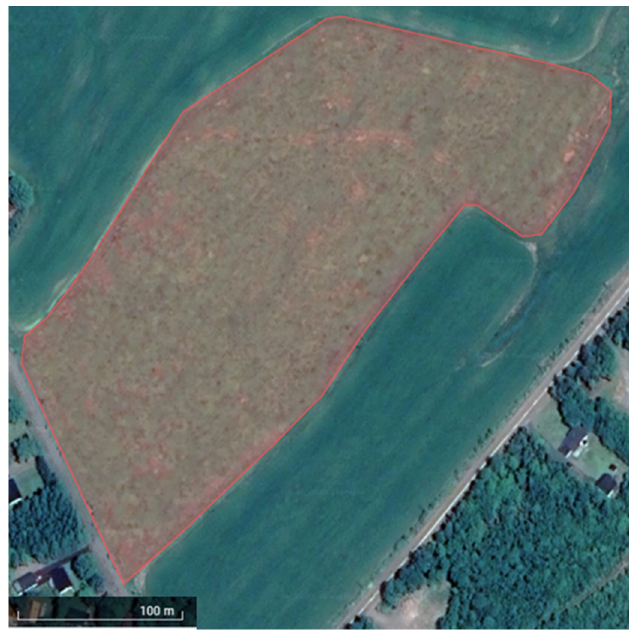
Figure 3. Boundary map for Debert field.